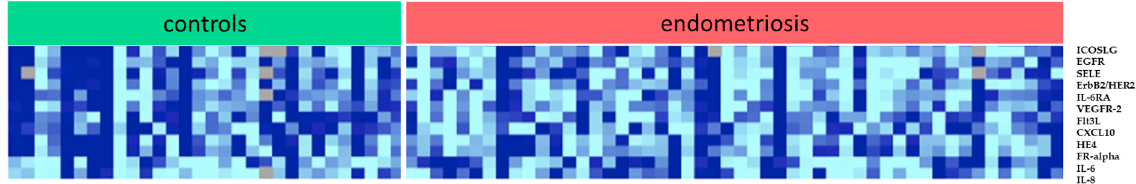
Figure 1. Heat map representing the target proteins that showed a significant difference in expression between patients with endometriosis (DIE and endometriosis patients without DIE) and controls. The color intensity corresponds to the expression level of the protein. DIE, deep-infiltrating endometriosis. Twelve biomarkers significantly differed between endometriosis patients and controls. Ten of